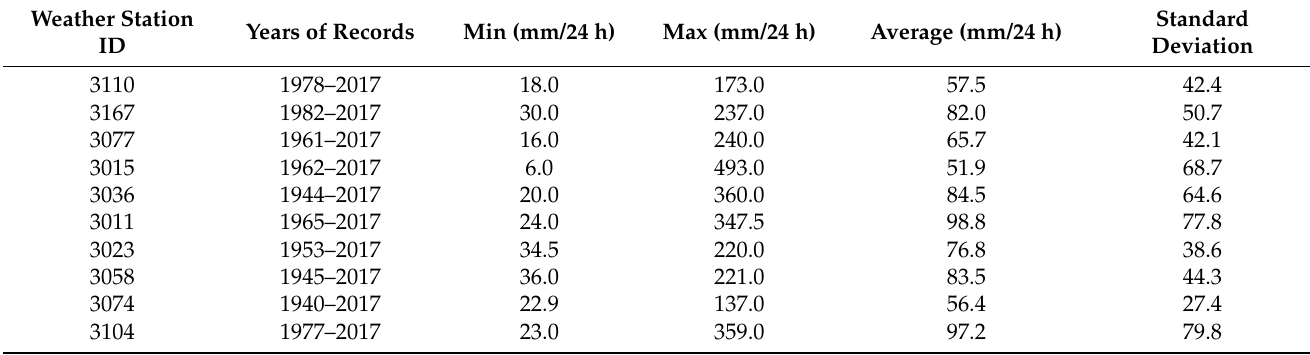
Table 1. Statistical analysis of rainfall data from SMN weather stations.